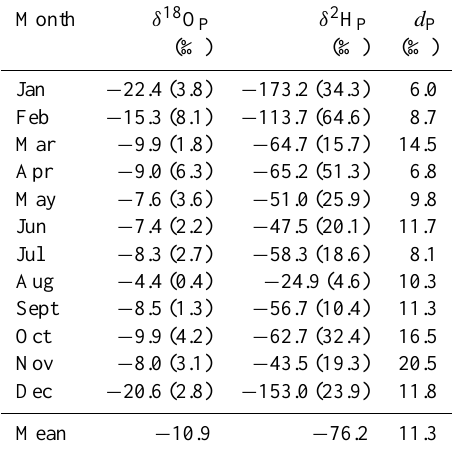
Table 2. Precipitation isotope climatology. Precipitation isotope composition δ 18 O P and δ 2 H P (‰) are reported as amounted weighted values for the period 2010 to 2011. Deuterium excess of precipitation ( d P , ‰) was calculated from the monthly flux- weighted values. All values in parentheses represent 1 standard de- viation for the specified